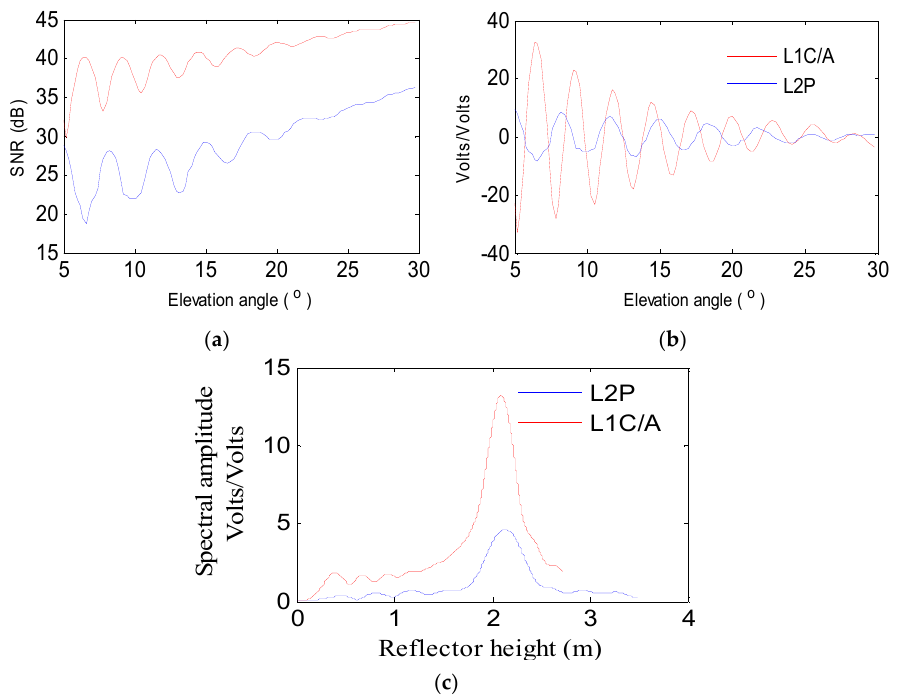
Figure 4. Comparison of simulated L1C/A and L2P SNR observables. ( a ) Simulated L1C/A and L2P SNR; ( b ) Multipath modulations; ( c ) Lomb–Scargle periodogram of multipath pattern.